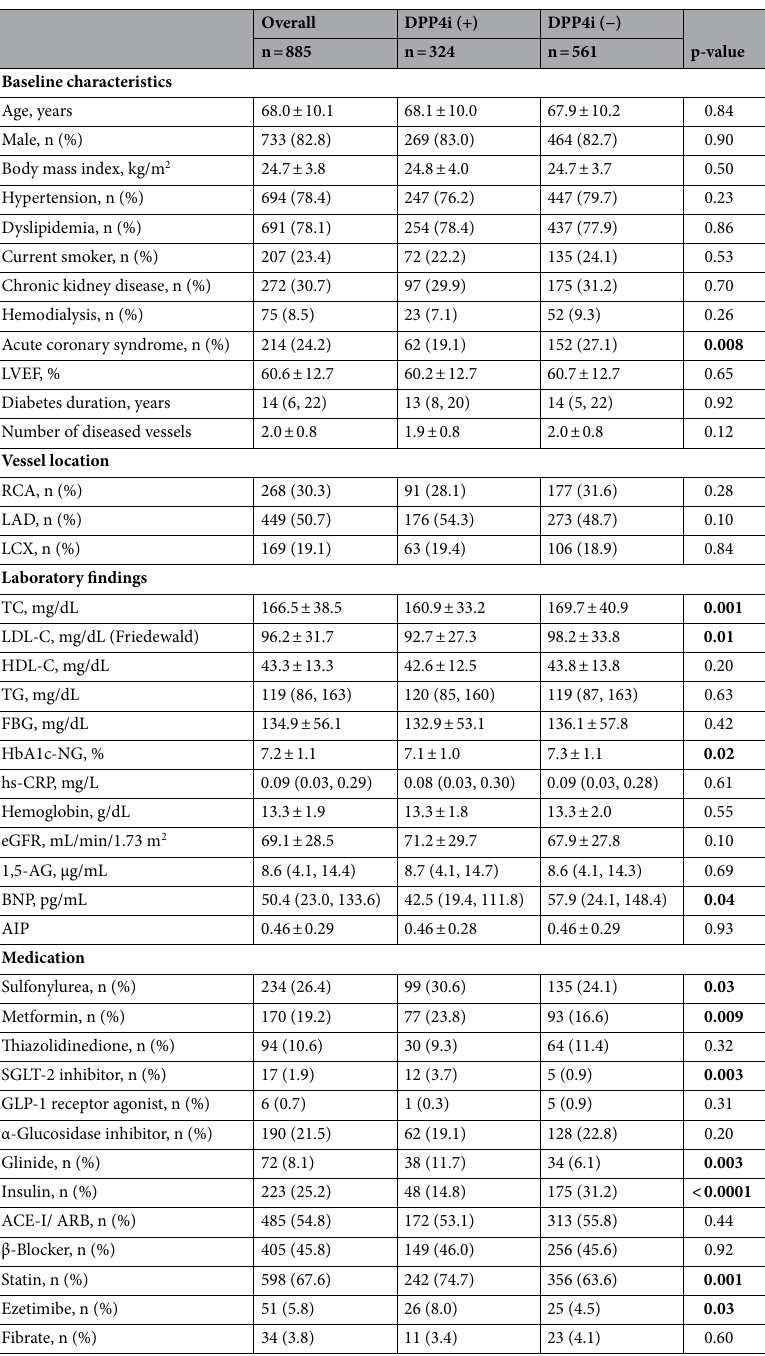
Table 1. Baseline characteristics of study patients. LVEF left ventricular ejection fraction, RCA right coronary artery, LAD left anterior descending artery, LCX left circumflex artery, TC total cholesterol, LDL-C low-density lipoprotein, HDL-C high-density lipoprotein, TG triglycerides, FBG fasting blood glucose, HbA1c-NG glycated hemoglobin, hs-CRP high-sensitivity C-reactive protein, eGFR estimated glomerular filtration rate, 1,5-AG 1,5-anhydroglucitol, BNP b-type natriuretic peptide, AIP atherogenic index of plasma (Log TG/HDL-C), SGLT-2 sodium–glucose co-transporter-2, GLP-1 glucagon-like peptide-1, ACE-I angiotensin-converting enzyme inhibitors, ARB angiotensin receptor